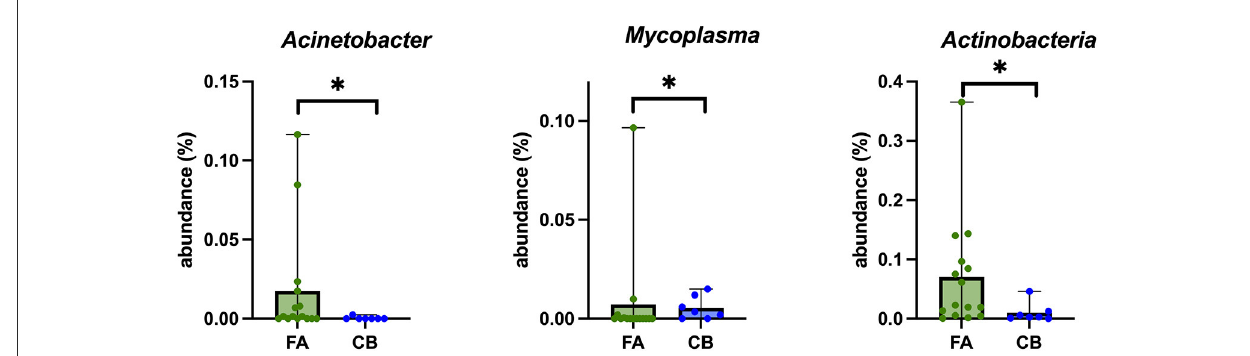
FIGURE4 Box plots of bacterial taxonomic groups that were significantly different in BALF-samples of cats with feline asthma (FA; green dots) and chronic bronchitis (CB; blue dots). Median is represented by the upper limit of the colored boxes, range is represented by the upper and lower thin lines. * p <